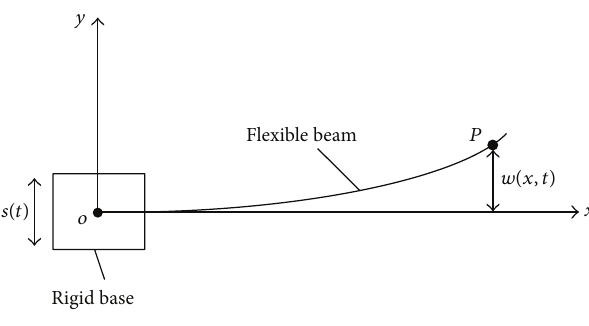
Figure 2: Dynamic model of the FMMB.